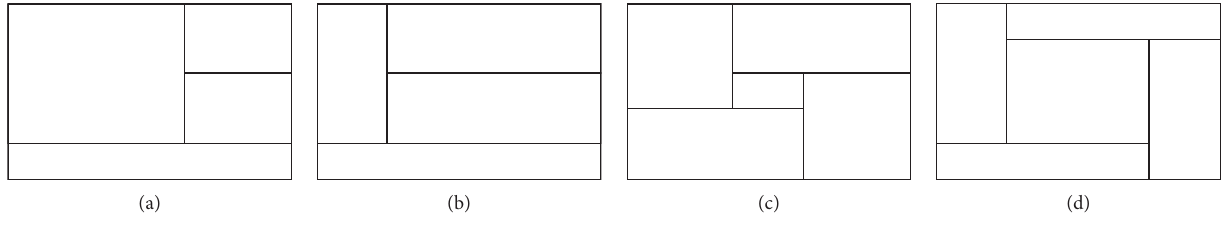
Figure 1: Four variants of the 2DRSSSCSP: (a) 2DRSSSCSP-GO. (b) 2DRSSSCSP-GR. (c) 2DRSSSCSP-FO. (d) 2DRSSSCSP-FR.